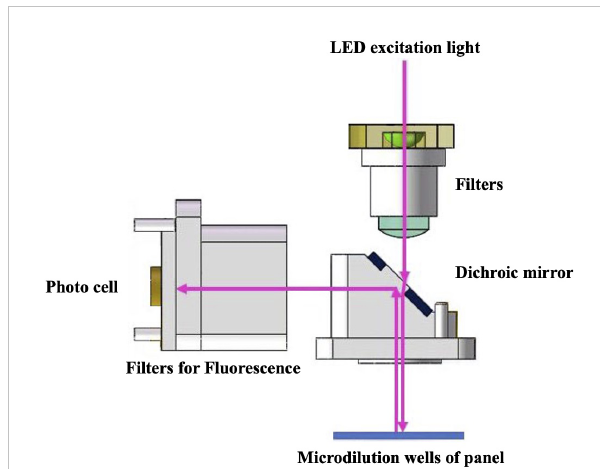
FIGURE 1 Automated antimicrobial susceptibility testing system, Droplet 48, uses the re fl ection fl uorescence detection device to obtain fl uorescence intensity change in microdilution wells. The fl uorescence detection device has advantages of fast detection speed and avoidance of stray light interference. A stable light source with fi xed band generated by monochromatic LED light source is used as an excitation light to illuminate the detection microdilution wells of the panel after fi ltering stray light using a fi lter and splitting by dichroic mirror. The panel continuously sampled the re fl ected light during the rotation process, and the fl uorescence intensity was obtained through a high-sensitivity photocell. Software analysis processes the collected fl uorescence data through a variety of algorithms to fi t a characteristic growth